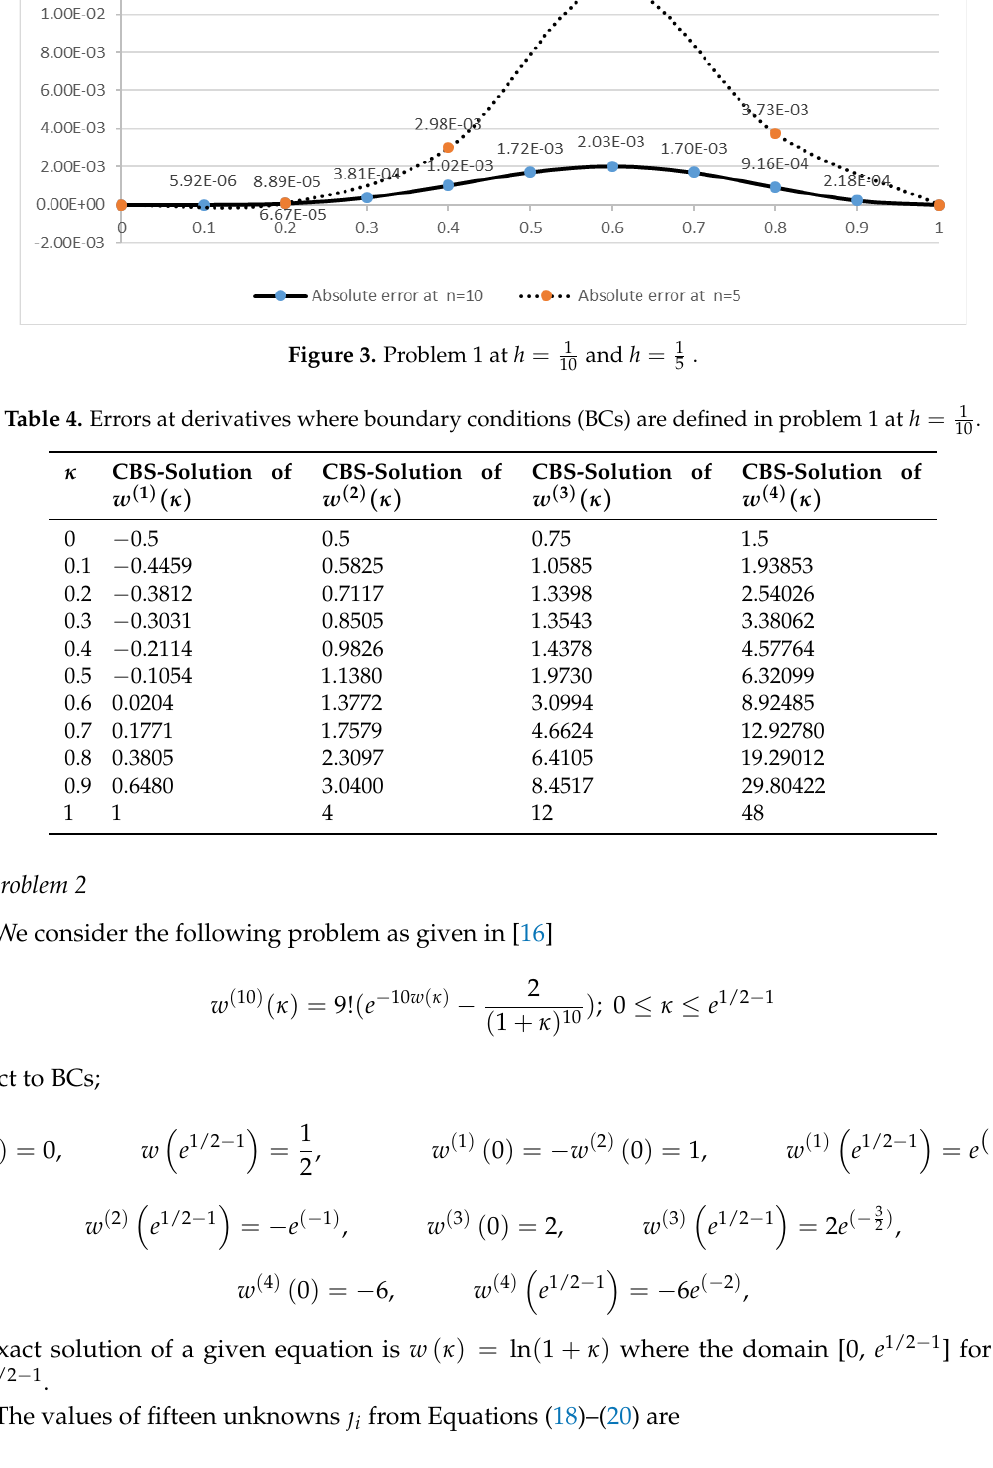
Figure 3. Problem 1 at h = 1